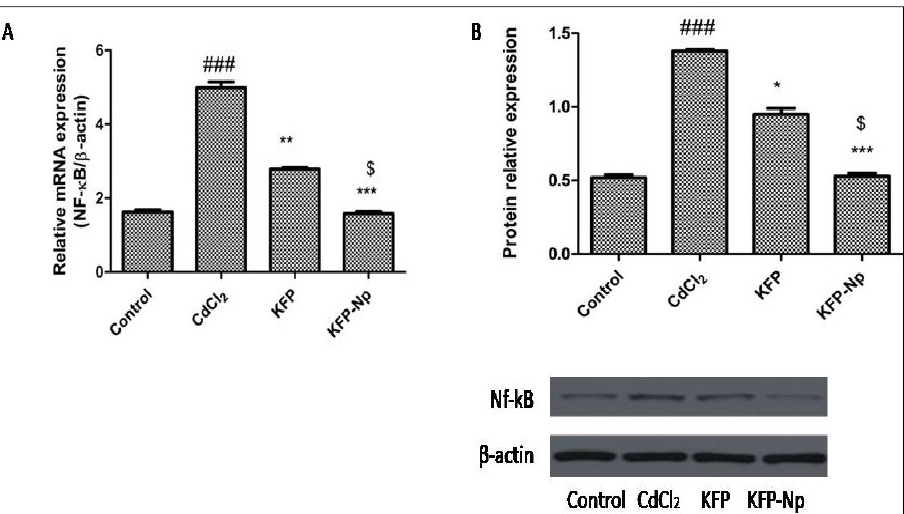
Figure 10. The effects of KFP-Np on nuclear factor-kappa B (NF- κ B) (p65) mRNA expression by RT-PCR ( A ), and protein expressions by western blot analysis ( B ). ### p < 0.001 significantly different from control group; * p < 0.05, ** p < 0.01 and *** p < 0.001, significantly different from the CdCl 2 groupand $ p < 0.05, significantly different from the KFP group.